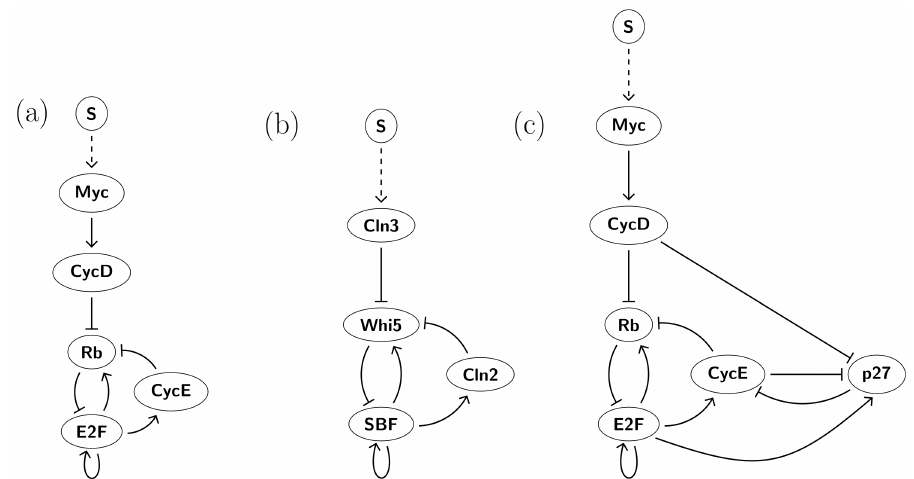
Fig 5. Comparison between human and yeast networks. (a) The best 5-node network from Fig 4(b) that exhibits the most robust full path and partial path hysteresis. (b) Cell cycle initiation network from yeast (START network) [29, 30] exhibits robust resettable bistability in 23.81% of the full paths 12.8%. Because the networks in (a) and (b) only differ by a node with a single input and single output ( Myc ), the networks in (a) and (b) will give the same results in our analysis. (c) Best 5-node network from Fig 4(b) with added p27 shows full path resettable bistability in 6.43% and full path hysteresis in 0.35% of the corresponding parameter paths.